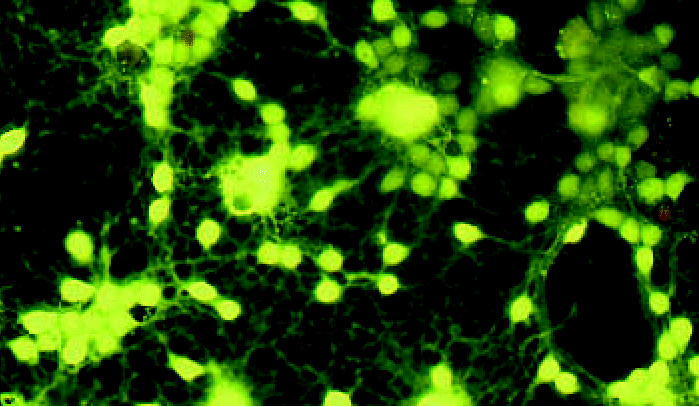
Young and vulnerableImmature neurons called granule cells are more sensitive to genotoxicants.